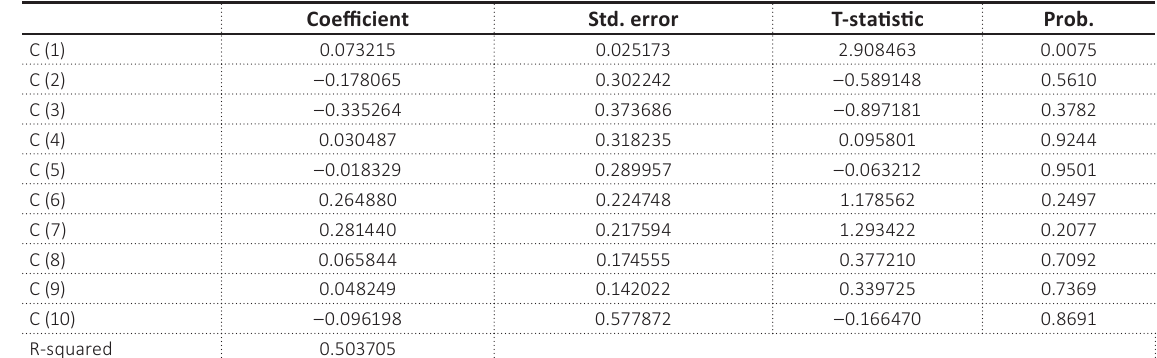
Source: Output extract from EViews software.